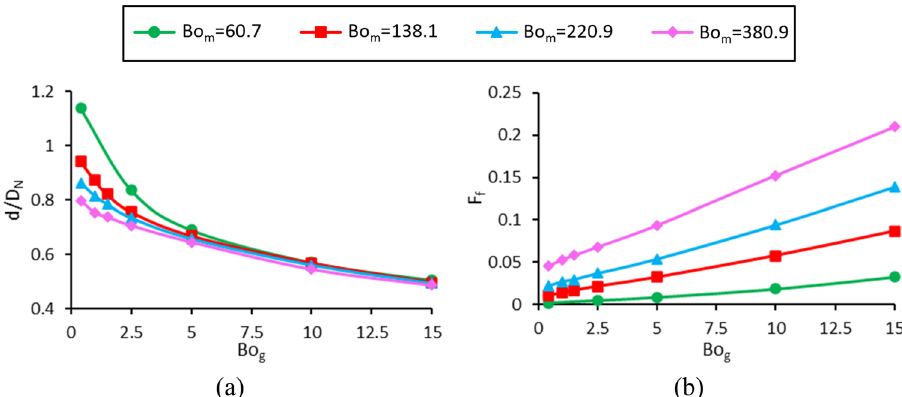
Figure 13. Variations in ( a ) the dimensionless droplet diameter and ( b ) the dimensionless formation frequency in terms of the gravitational Bond number and different magnetic Bond numbers.